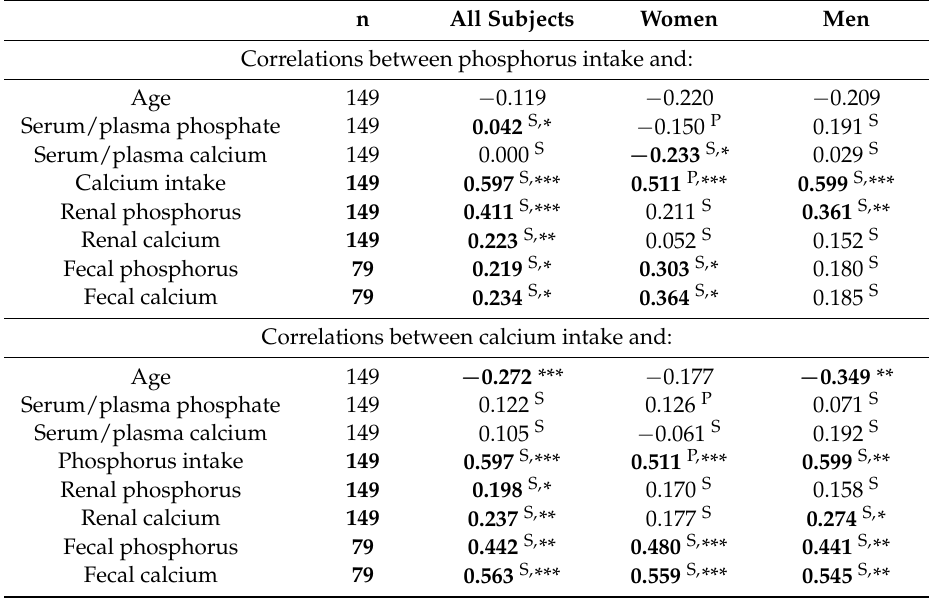
Table 4. Associations between phosphorus and calcium intake with parameters of phosphorus and calcium status. n All Subjects Women Men Correlations between phosphorus intake